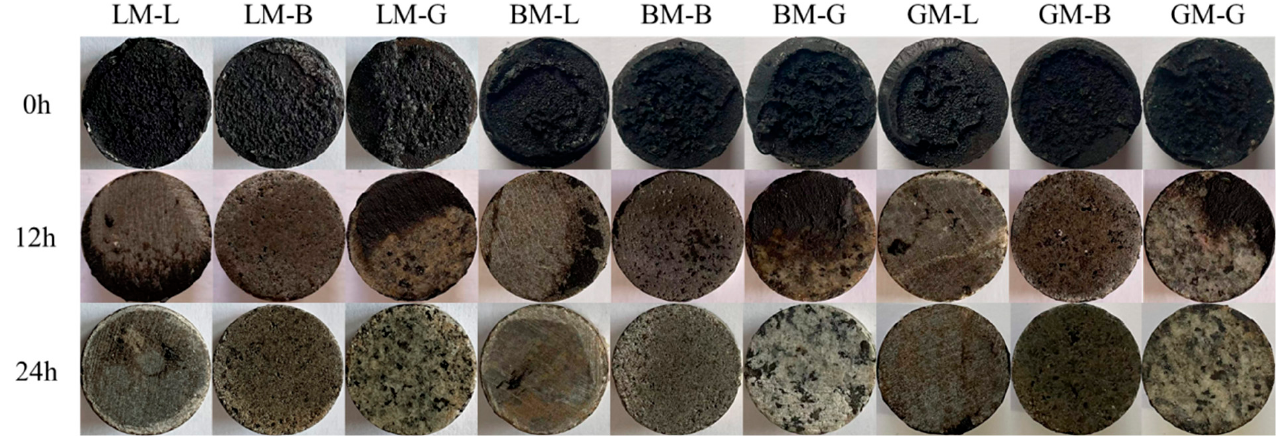
Figure 15. Failure of asphalt mortar–aggregate interfaces under water pressure.